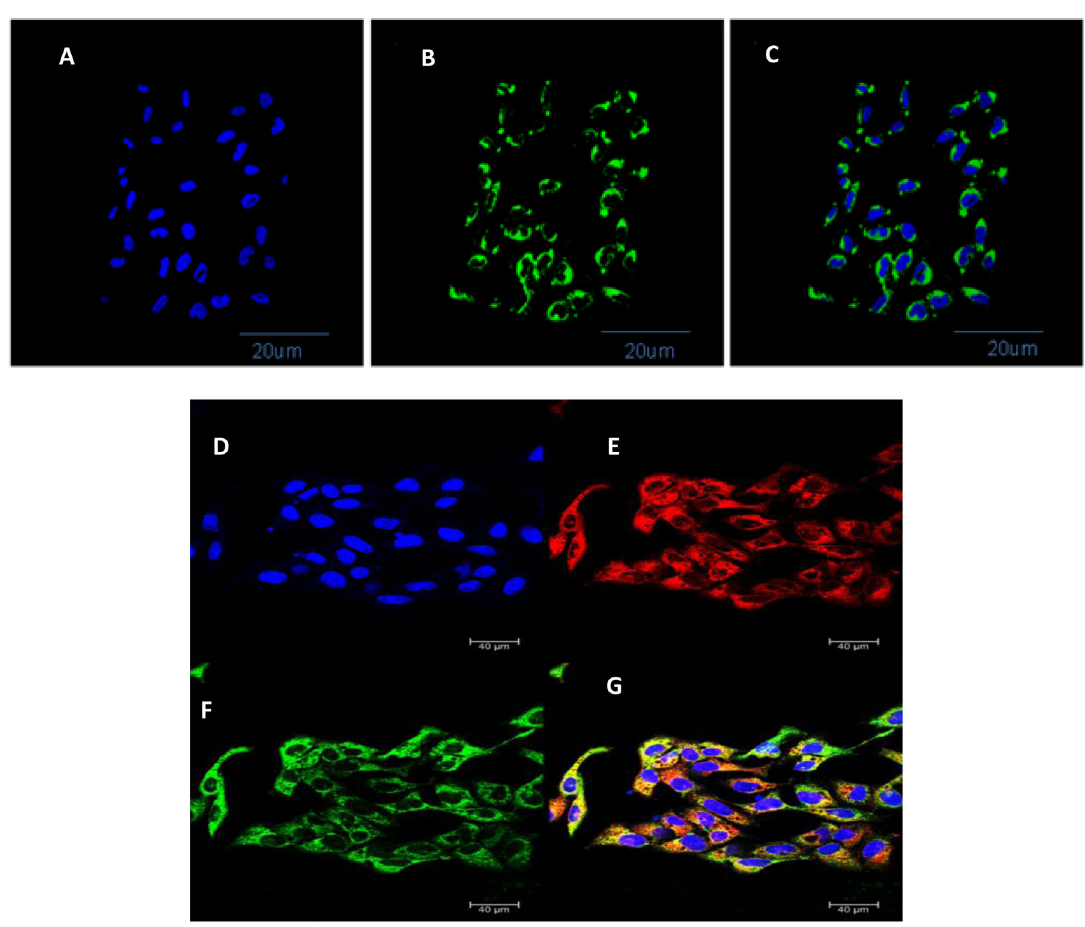
Fig. 7 Results of the confocal microscopy images for cellular inter- nalization of coumarin-6-loaded PLGA NPs. A is image of channel 1 that shows nucleus of the cells stained with DAPI (blue). B shows channel 2 showing the presence of coumarin-6-loaded PLGA NPs (Green) in the cellular cytoplasm. C shows channel 3, demonstrating an overlay of channels 1 and 2. D is the image of channel 1 that shows